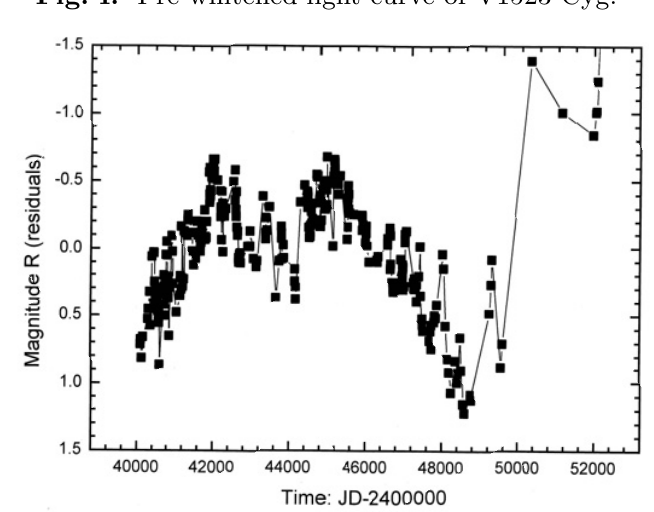
Fig. 4. Pre-whitened light curve of V1523 Cyg.